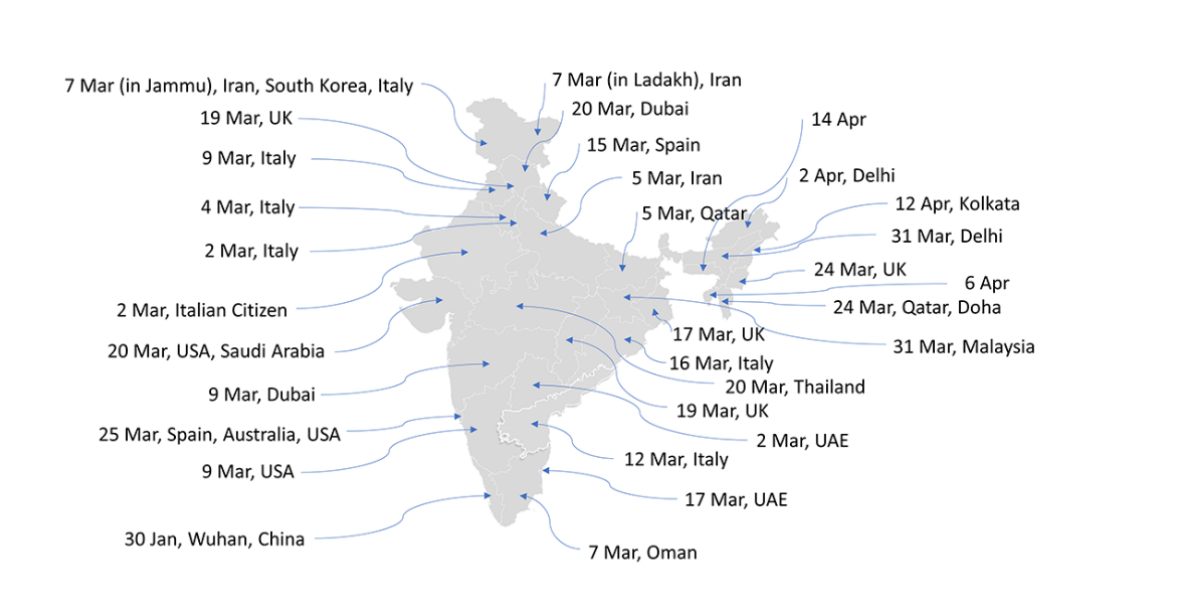
Figure 2. When the first case in each state happened with their travel histories. UAE: United Arab Emirates.